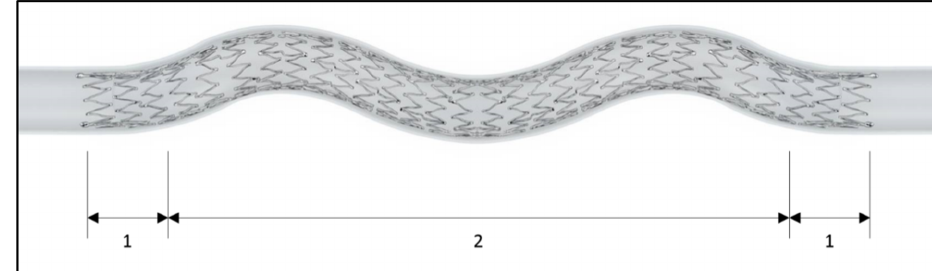
Figure 1. Unconstrained BioMimics 3D stent. The BioMimics 3D stent has a helical centreline (2) and transition sections (1). The last 3 crowns at the stent ends define the transition sections, where the length of the crown is increased, slightly reducing the radial force imposed on the vessel, thus mit- igating a step-change in the profile at the stent ends. Image provided by Veryan